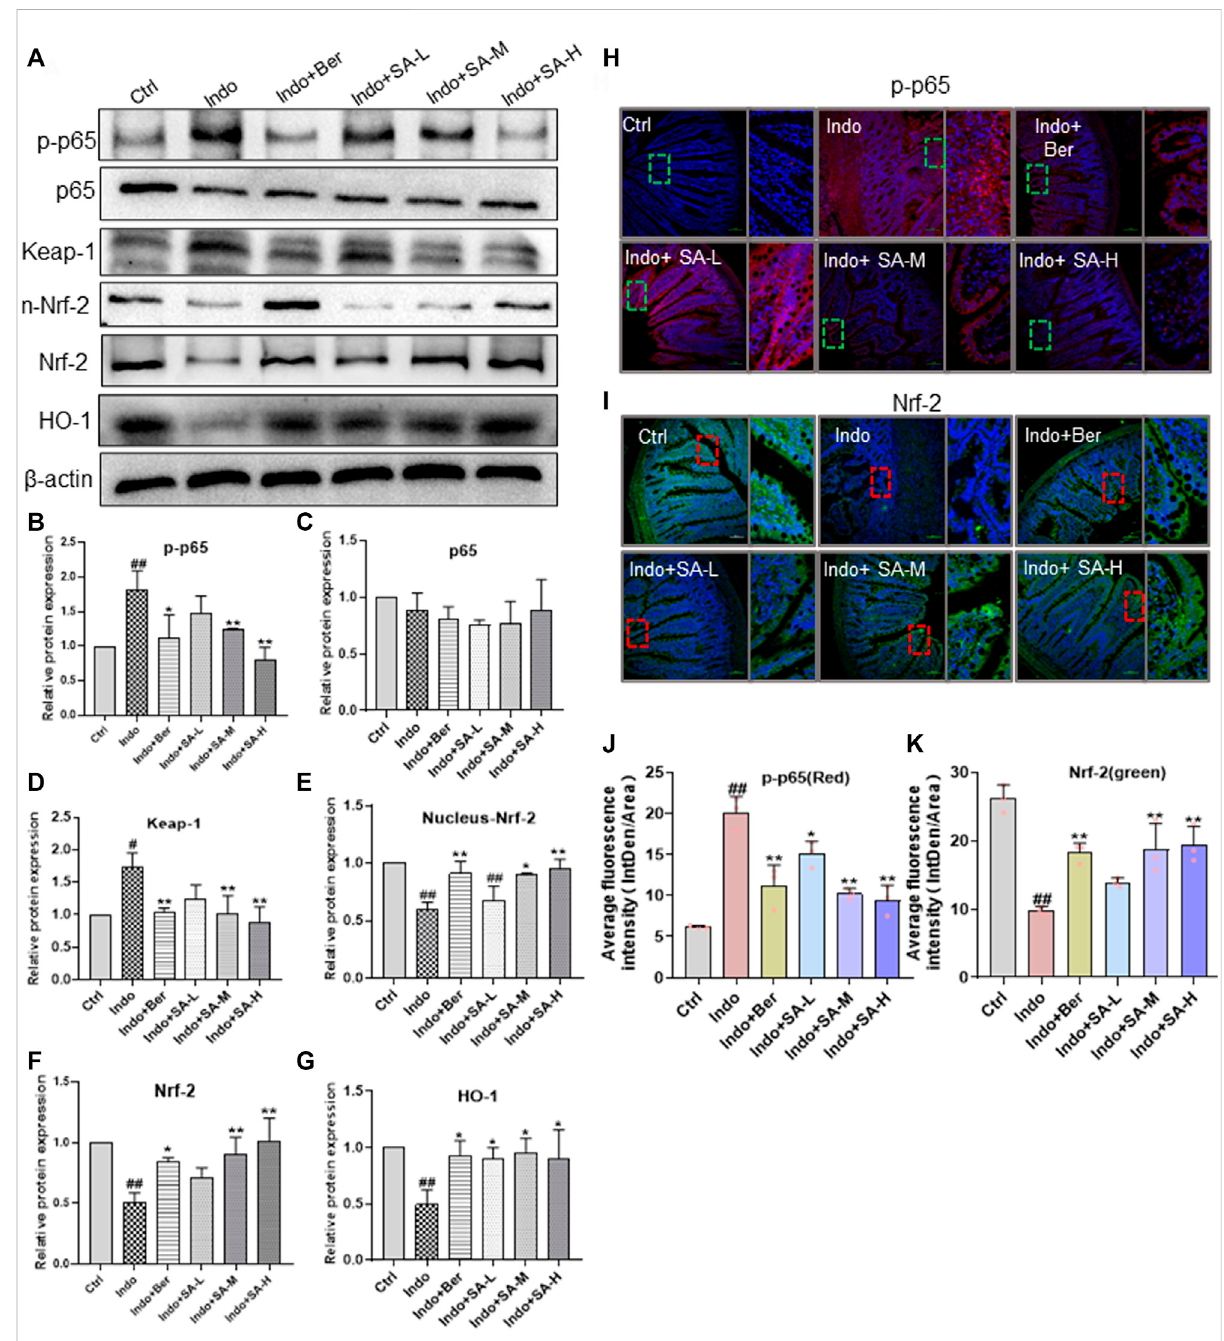
FIGURE 4 SA inhibited the NF- κ B expression but increased Nrf2 and HO-1 expression in small intestinal mucosa of indomethacin-treated rats. Male SD ratsweretreatedwithindomethacin(Indo,7.5 mg kg − 1 )aloneorwithsanguinarine(SA,0.33 mg kg − 1 ,1.0 mg kg − 1 ,3.3 mg kg − 1 ,SA-L,SA-MandSA-H, respectively) or with berberine (Ber, 60 mg kg − 1 ). Protein was extracted from rat jejunum and tissue sections were prepared. (A – G) Protein levels of NF-KB p-p65, Keap-1, Nrf2, nucleus-Nrf2 and HO-1 evaluated by western blotwith β -actin as an internal control. Data were calculated from at least three independent experiments. (H-K) Location and expressions of NF-kB p-p65 and Nrf2 in jejunum were detected by laser confocal immuno fl uorescence assay (magni fi cation at ×200). NF-kB p-p65 and Nrf2 were labeled with FITC-red and FITC-green, respectively. The nuclei were stained with DAPI. The small box represents the typical fl uorescence area, which is enlarged and placed to the right of the whole fl uorescence fi eld. Data are presented as the mean ± SD ( n = 3). # p < 0.05 and ## p < 0.01 vs. control (Ctrl). * p < 0.05 and ** p < 0.01 vs. indomethacin